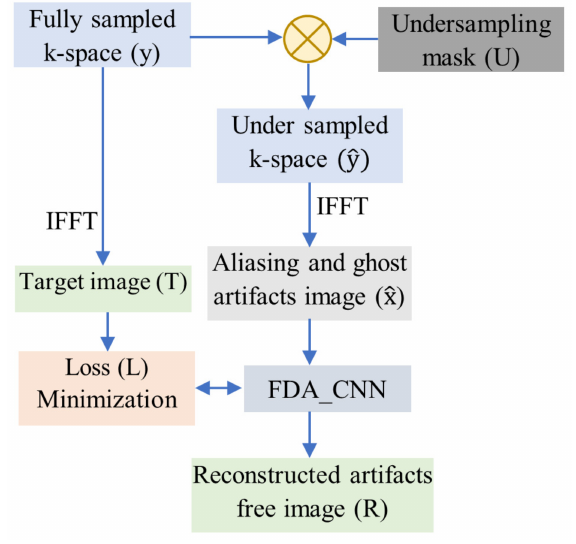
Figure 2. Flowchart of the proposed de-aliasing